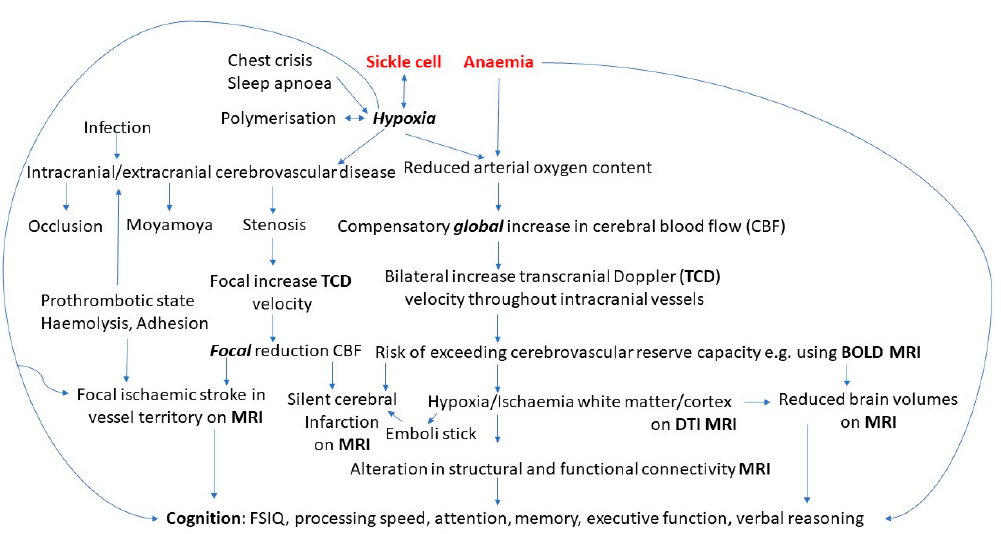
Figure 1. Pathophysiology of cognitive difficulties in sickle cell disease.